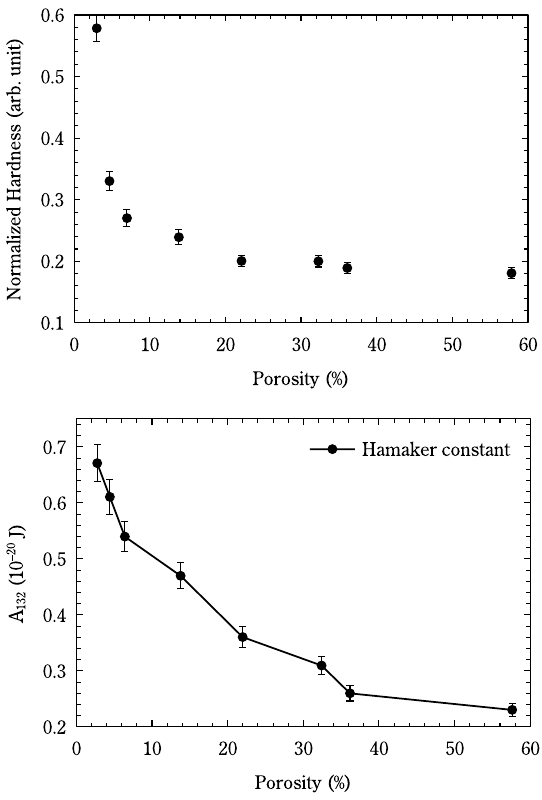
Fig. 4.2a: Change in hardness (on left) and Hamaker constant (on right) of silica particles with porosity (Reprinted from refer- ence 37).